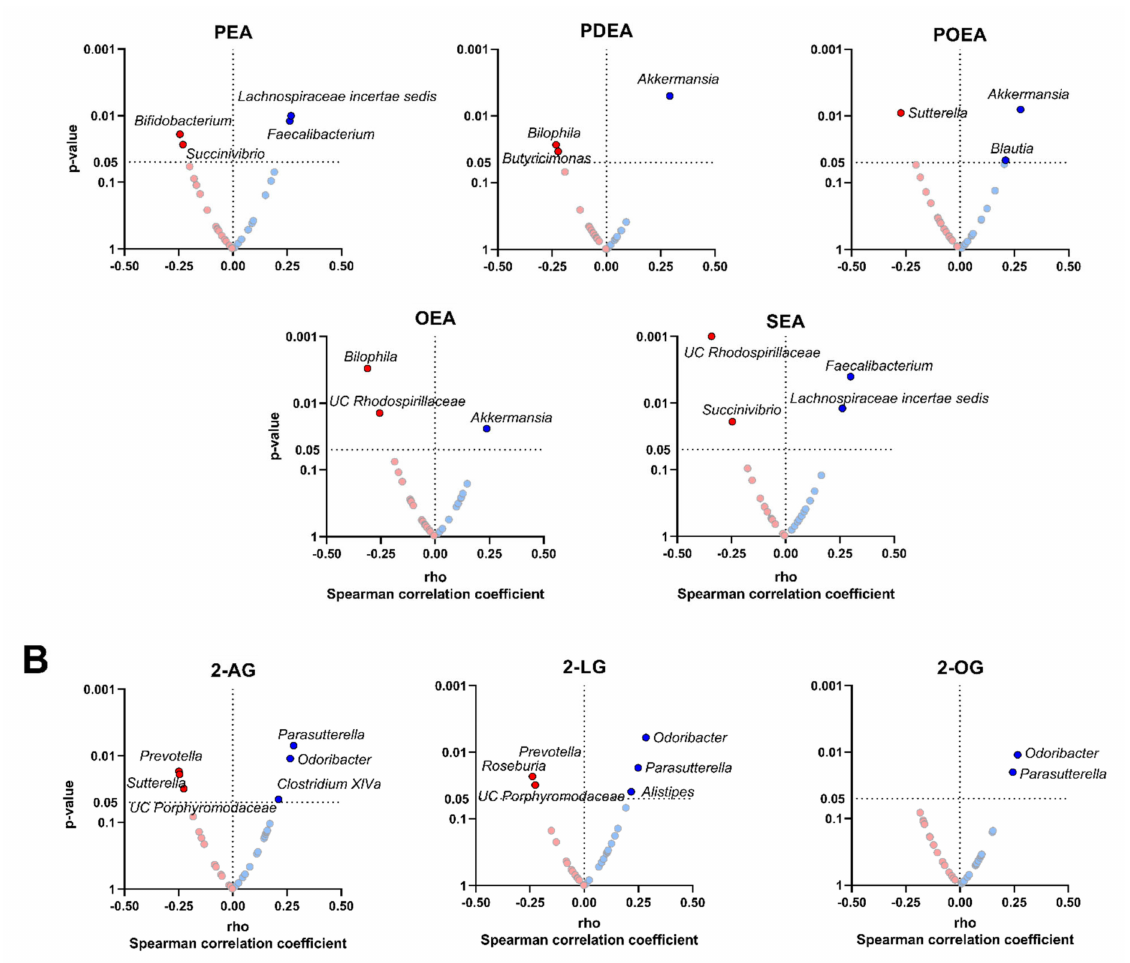
Figure 2. Volcano plots showing partial Spearman correlations of plasma levels of endocannabinoids and their analogues with fecal microbiota composition at genus taxonomic level. Each volcano plot shows the rho coefficients in the X-axis, whereas the p -values of the correlations are shown on the Y-axis. Panel ( A ) shows AEA and related N-acylethanolamines and panel ( B ) shows 2-AG and acylglycerols. Red circles indicate negative correlations, whereas blue circles indicate positive correla- tions. Body mass index was included as a confounder in these correlations. Only those genera with significant p -values ( p < 0.05) are annotated within the figure. 2-AG: 2-arachidonylglycerol; 2-LG: 2- linoleoylglycerol; 2-OG: 2-oleoylglycerol; alpha LEA: alpha-Linolenoyl ethanolamide; AA: arachi- donic acid; AEA: anandamide; DGLEA: dihomo-gamma-linolenoyl ethanolamide; DHEA: docosa- hexaenoyl ethanolamide; LEA: linoleoyl ethanolamide; OEA: oleoyl ethanolamine; PEA: palmitoyl ethanolamide; PDEA: pentadecanoyl ethanolamide; POEA: palmitoleoyl ethanolamide; SEA: stearoyl ethanolamide; UC: